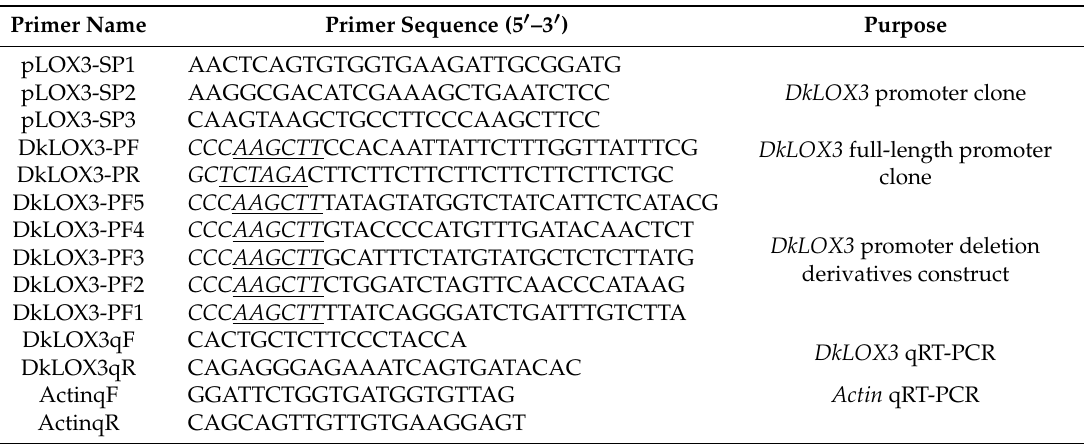
Table 1. Oligonucleotide sequences for primers used in this